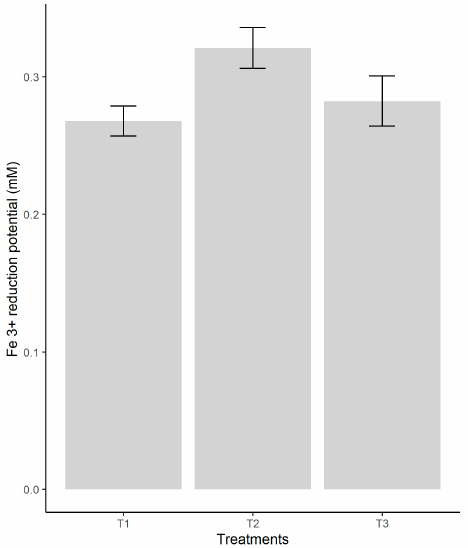
Figure 3. Reducing activity according to the type of substrate used in the cultivation of P. ostreatus